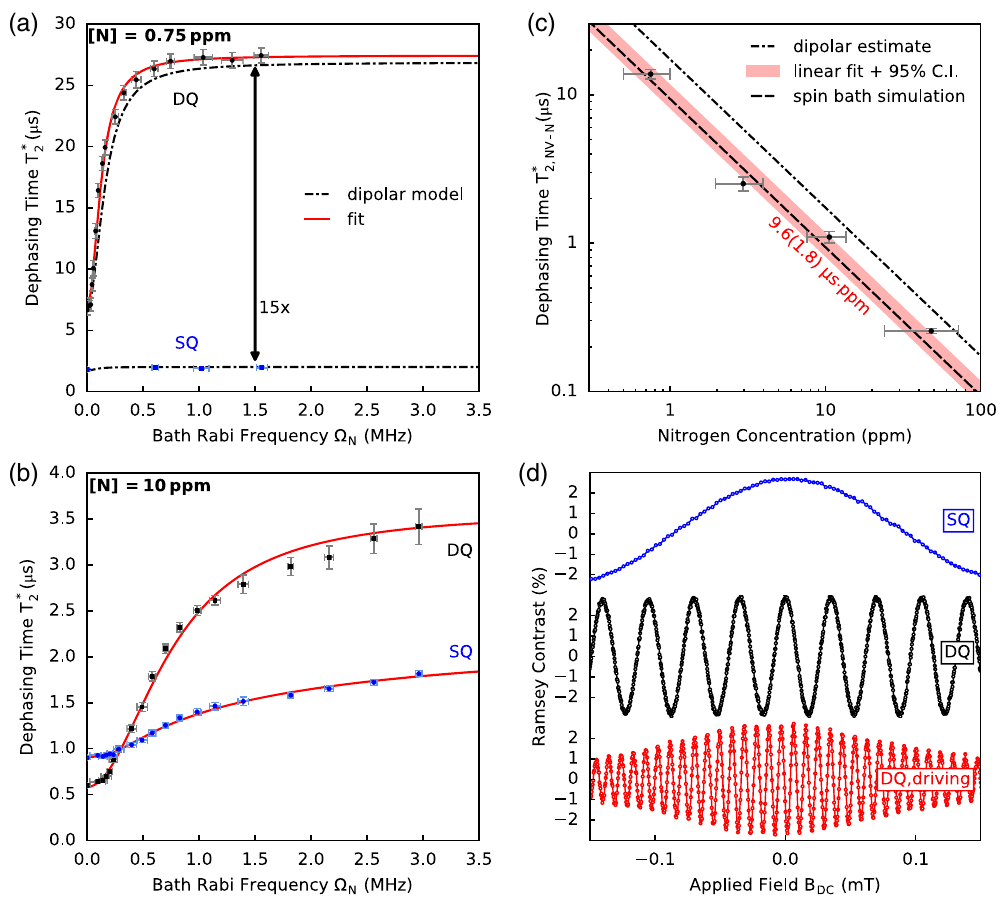
FIG. 4. Application of quantum control techniques to extend NV spin ensemble dephasing time ( T (cid:1) 2 ) and increase dc magnetic-field sensitivity. (a) Ramsey measurements of T (cid:1) 2 in the single quantum (SQ, blue) and double quantum (DQ, black) bases for different spin- bath drive strengths (Rabi frequencies) for sample B ( ½ N (cid:5) ¼ 0 . 75 ppm) at B 0 ¼ 8 . 5 mT. The black dashed-dotted line is calculated from a model of NV spins that are dipolar coupled to a multicomponent spin bath [Eq. (4)]. The red solid line is a fit of the model to the T (cid:1) 2 ≡ 2 × T (cid:1) data (see main text for details). (b) Same as (a) but for sample C ( ½ N (cid:5) ¼ 10 ppm) and B 0 ¼ 10 . 3 mT. (c) Measured T (cid:1) 2 ; 2 ; DQ NV-N as a function of nitrogen concentration for samples B, C, D, E. Samples were selected to have a predominately electronic nitrogen (P1) spin bath using DEER ESR measurements. The black dashed-dotted line is the dipolar-interaction-estimated dependence of T (cid:1) 2 on nitrogen concentration (Supplemental Material Sec. V [28]). We fit the data using an orthogonal-distance-regression routine to 2 π × 16 . 6 ð 2 . 6 Þ kHz = ppm account for the uncertainties in [N] and T (cid:1) 2 . A fit to the form 1 =T (cid:1) 2 ¼ A N (cid:5) yields A NV-N ½ N-NV ¼ 9 . 6 ð 1 . 8 Þ μ s · ppm]. The red shaded region indicates the 95% standard error of the fit value for A . The black dashed [ 1 =A NV-N ¼ NV-N line is the expected scaling extracted from numerical simulations using a second-moment analysis of the NV ensemble ESR linewidth (see text for details). (d) Measured Ramsey dc magnetometry signal S ∝ C sin ½ ϕ ð τ Þ(cid:5) for sample B, in the SQ and DQ bases, as well as the DQ sub-basis with spin-bath drive (see main text for details). There is a 36 × faster oscillation in the DQ sub-basis with spin-bath drive compared to SQ with no drive. This greatly enhanced dc magnetic-field sensitivity is a direct result of the extended T (cid:1) 2 , with the p ffiffiffiffiffiffiffiffiffiffiffiffiffiffiffiffiffiffiffiffiffiffiffiffiffiffiffi = τ τ at equal contrast. The slight decrease in observed contrast in the DQ þ drive case sensitivity enhancement given by 2 × DQ þ Drive SQ > 0 . 05 mT is a result of changes in the Zeeman resonance frequencies of the nitrogen spins due to the applied test field B for j B , dc j dc which was not corrected for in these